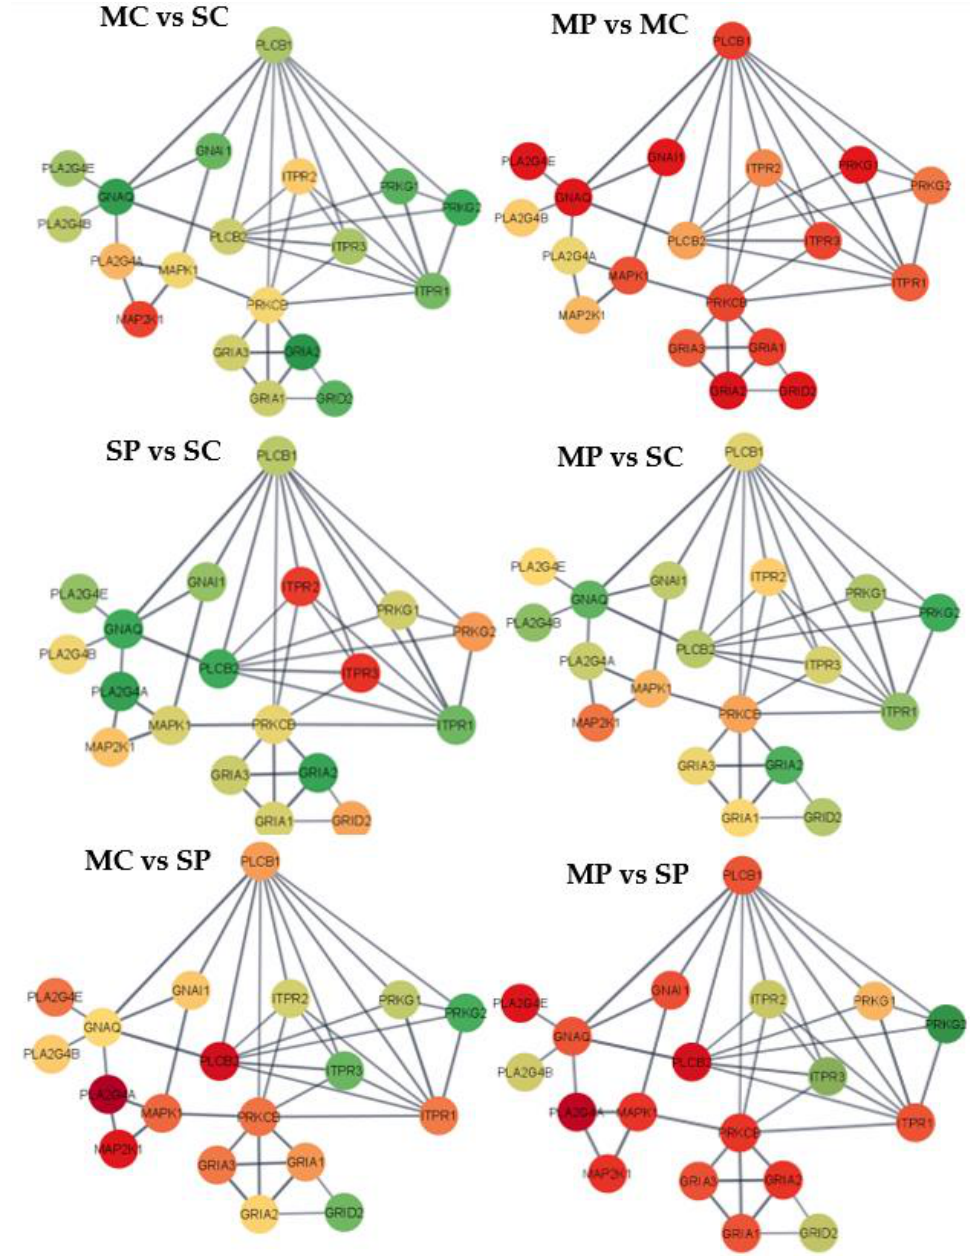
Figure 2. Gene networks for the long-term depression pathway. Nodes = genes; edges = STRING database connections; node color = differential expression between groups characterized by opioid (M = morphine or S = saline) followed by MIA exposure (C = control or P = viral MIA) from red (under-expressed in the first vs. second group, to yellow, and green (over-expressed in the first versus second group. Networks: MC vs. -SC = morphine-treated Control vs. saline-treated Control; MP-MC = morphine-treated MIA vs. morphine-treated Control; MC vs. SP = morphine-treated Control vs. saline-treated MIA; MP vs. SC = morphine-treated MIA vs. saline-treated Control; SP vs. SC = saline-treated MIA vs. saline-treated Control; and MP vs. SP = morphine-treated MIA vs. saline-treated MIA.